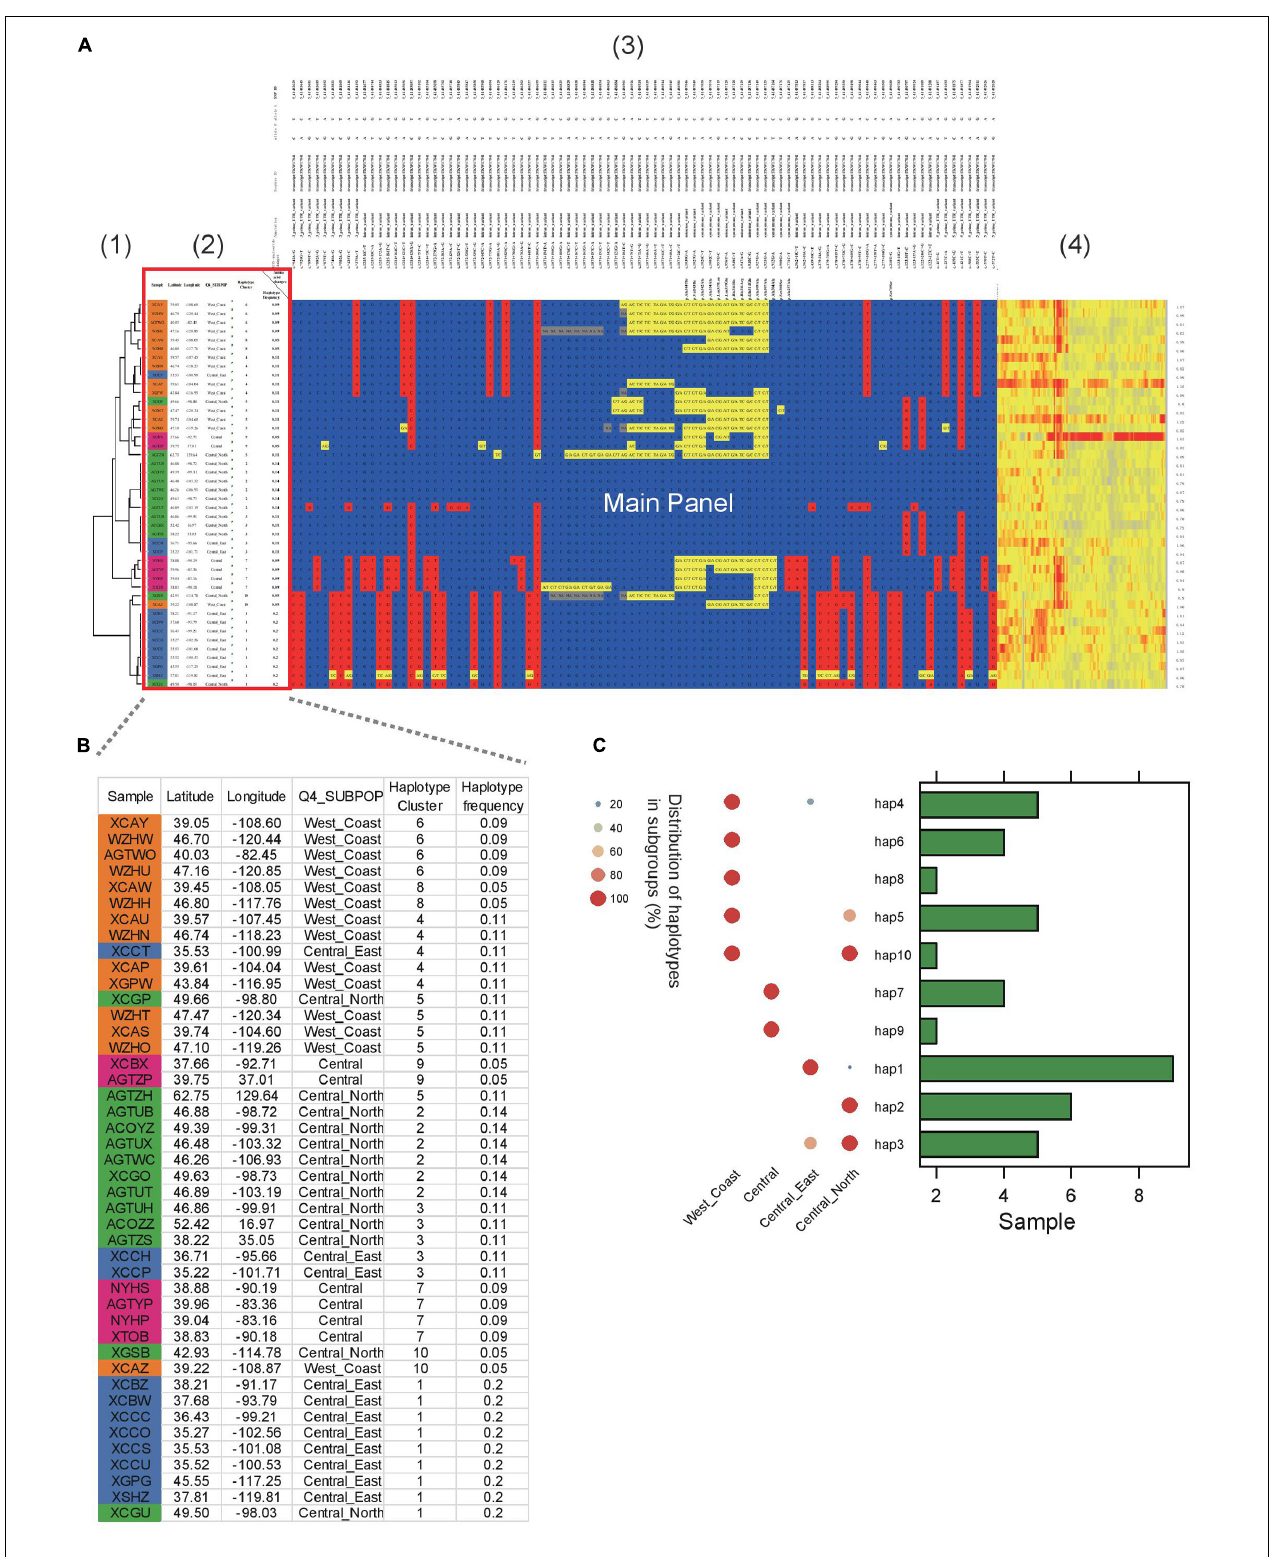
FIGURE 3 | Example of HAPPE on the display of the S. viridis gene Sevir.5G394700. (A) Haplotypes of the S. viridis gene Sevir.5G394700 with additional information, including (1) a tree, (2) descriptions of samples, (3) annotations of SNPs and (4) a heatmap of read depth. (B) Zoomed-in view of Panel 2 showing the details of the samples. (C) Distribution of haplotypes of the gene in different subgroups. More details can be found in Supplementary Tables 4–7 .